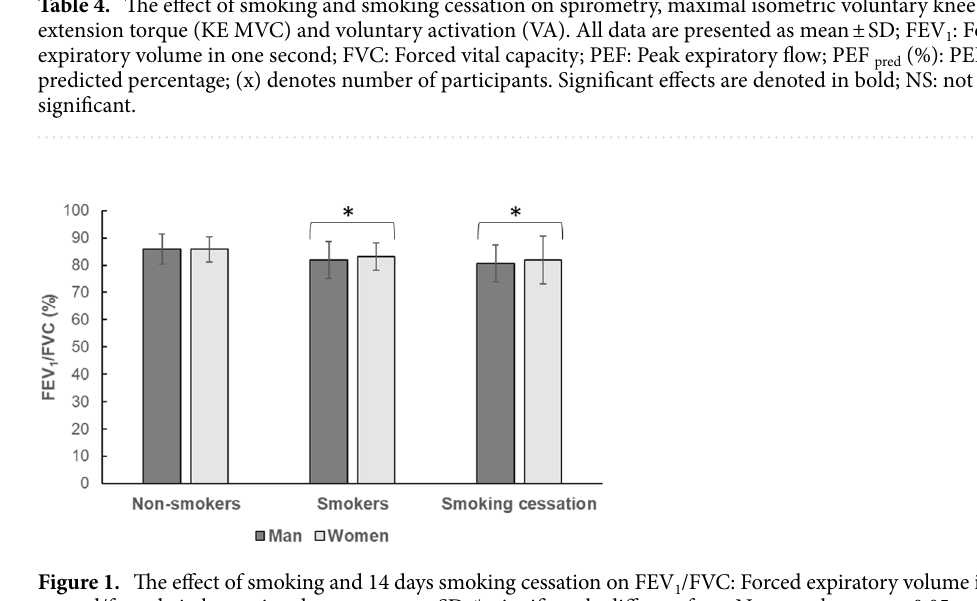
Figure 1. The effect of smoking and 14 days smoking cessation on FEV 1 /FVC: Forced expiratory volume in one second/forced vital capacity; data are mean ± SD; *: significantly different from Non-smokers at p < 0.05.